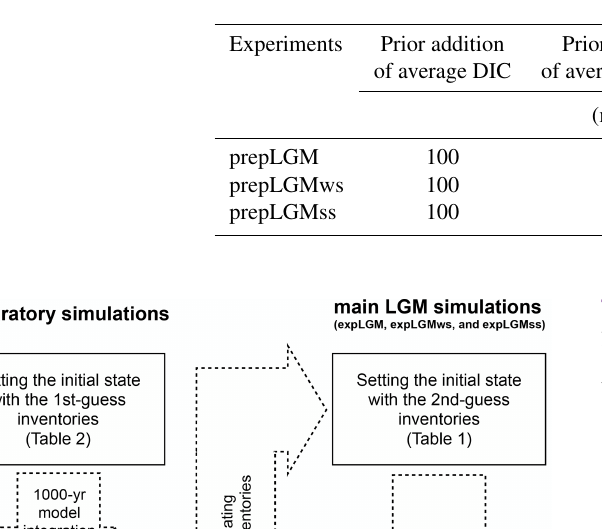
Table 2. The first-guess adjustment of the global mean concentrations of DIC and total alkalinity for the preparatory runs and the resultant DIC anomaly averaged over the depths of more than 2000m. In the last column, the differences between each of the LGM runs and expPI that are averaged over the last 50 years are shown.